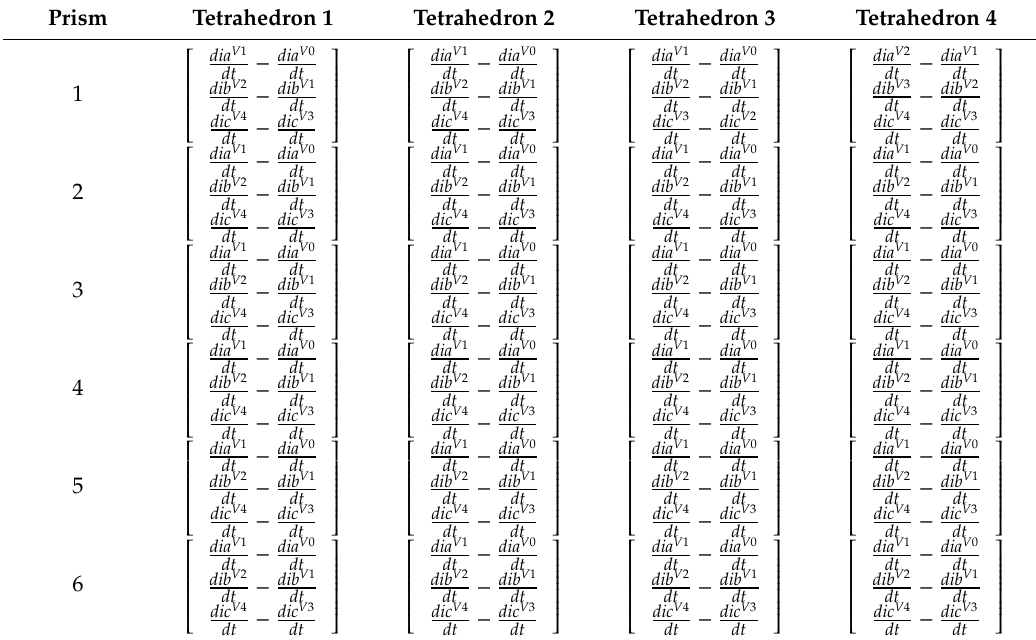
Table 5. Selection of the saturation saliency position scalars P a , P b , and P c for a fault-tolerant PMSM drive under normal operating